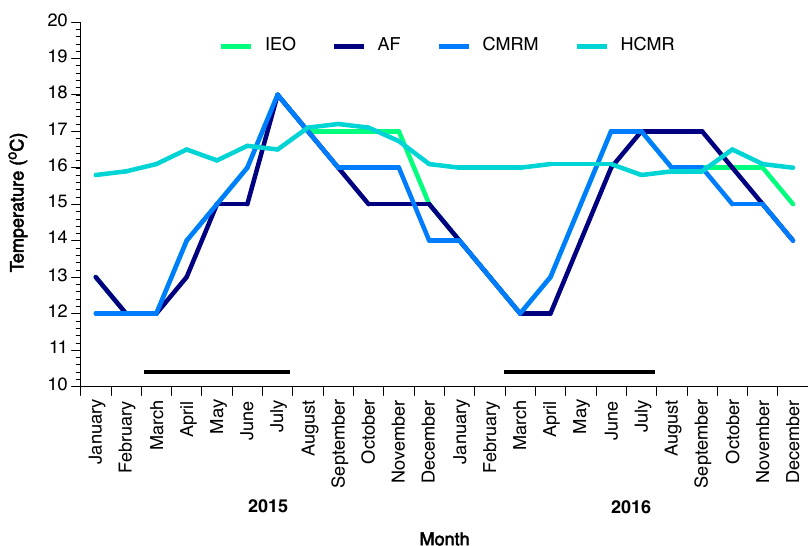
Figure 11. Tank water temperature ( ◦ C) of wreckfish broodstocks at four different sites: at the Hellenic Center for Marine Research (HCMR) in Greece, and at the Instituto Español de Oceanograf í a (IEO), the Aquarium Finisterrae (AF) and the Conselleria do Medio Rural e Mariño (CMRM) in Spain from January 2015 until December 2016. The temperature line of IEO overlaps with CMRM when not